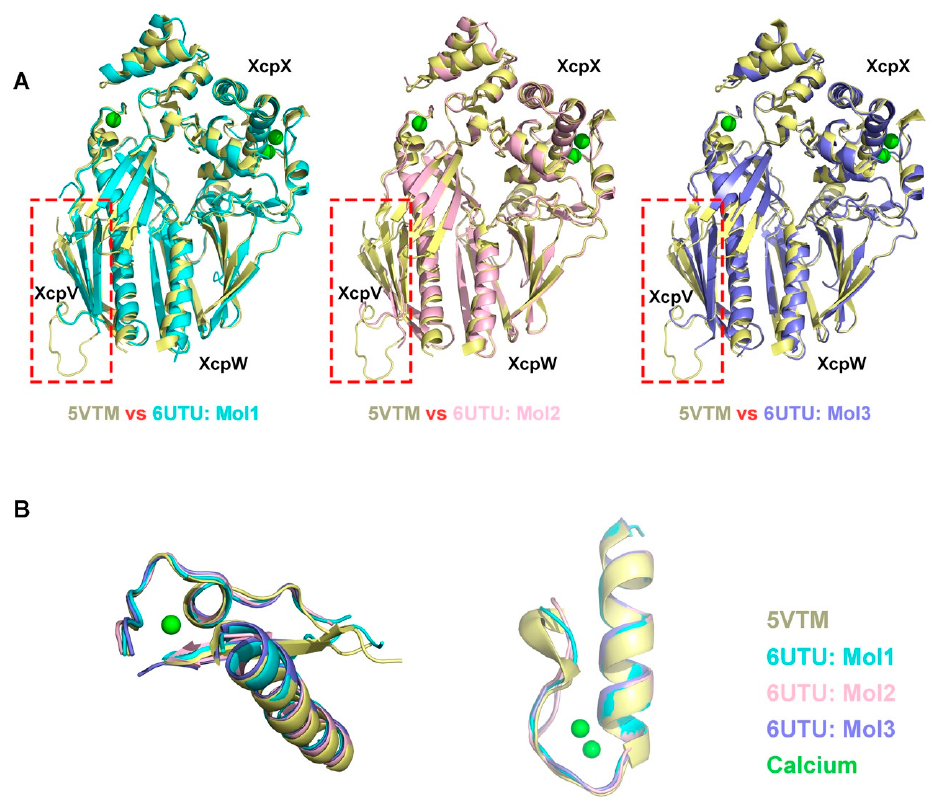
Figure 4. Comparison between the complex structure in the orthorhombic lattice and the ones in the hexagonal lattice. ( A ) The crystal structure of the XcpVWX ternary complex in the orthorhombic lattice (PDB ID: 5VTM) was superimposed onto the individual structures of three complex molecules in the hexagonal lattice (PDB ID: 6UTU). The regions in the dotted box show the main structural differences in pair-wise structure comparisons. ( B ) Calcium binding sites are identical in the four structures. Table 2. Missing residues in structures.